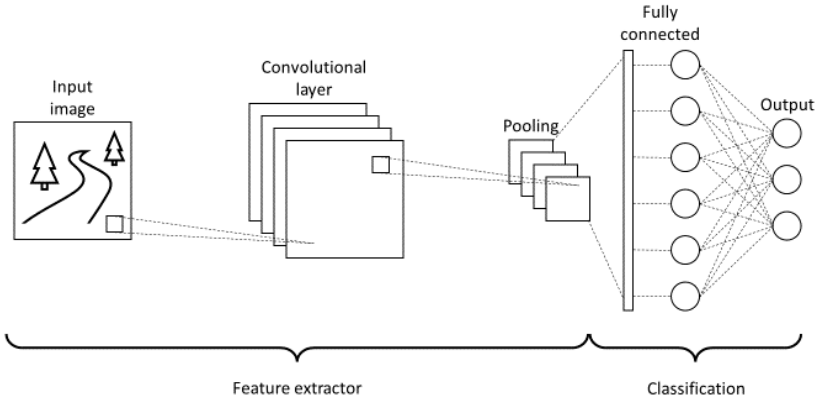
Figure 3. Simplified diagram of the structure of a CNN.